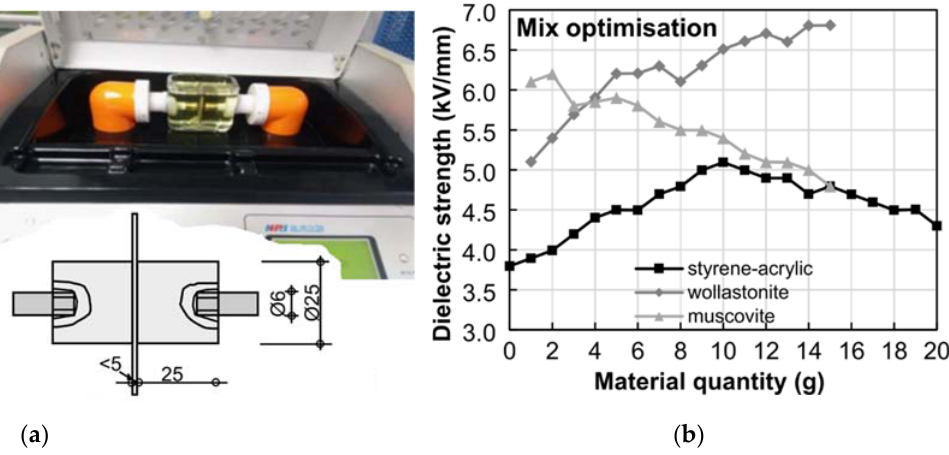
Figure 3. ( a ) Test machine and sketch of electrodes and specimen. ( b ) Change in dielectric strength with components added.